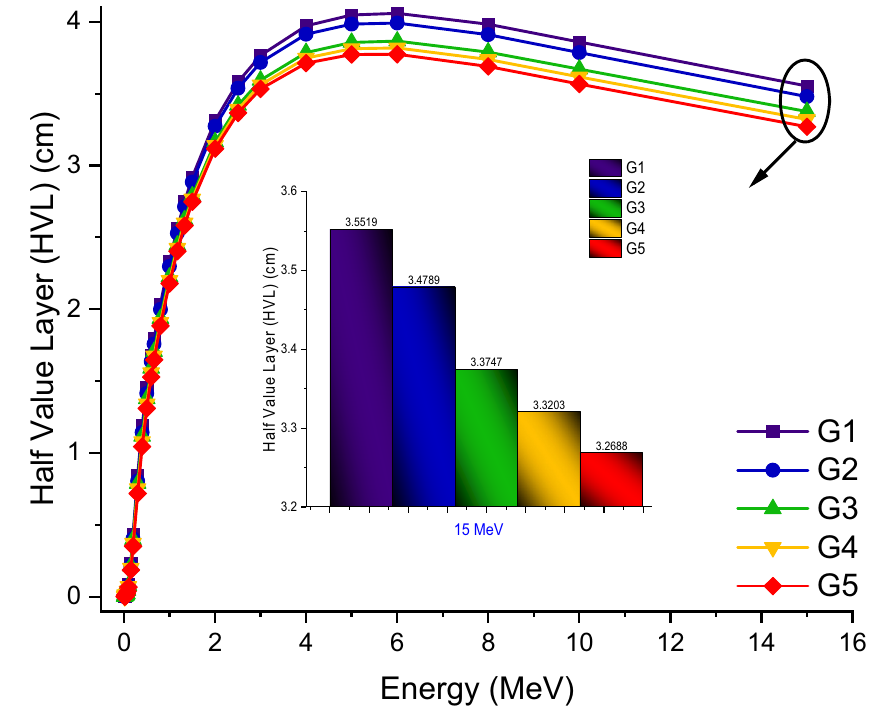
Figure 5: Variation of HVL ( cm ) with photon energy ( MeV ) for all G1 – G5